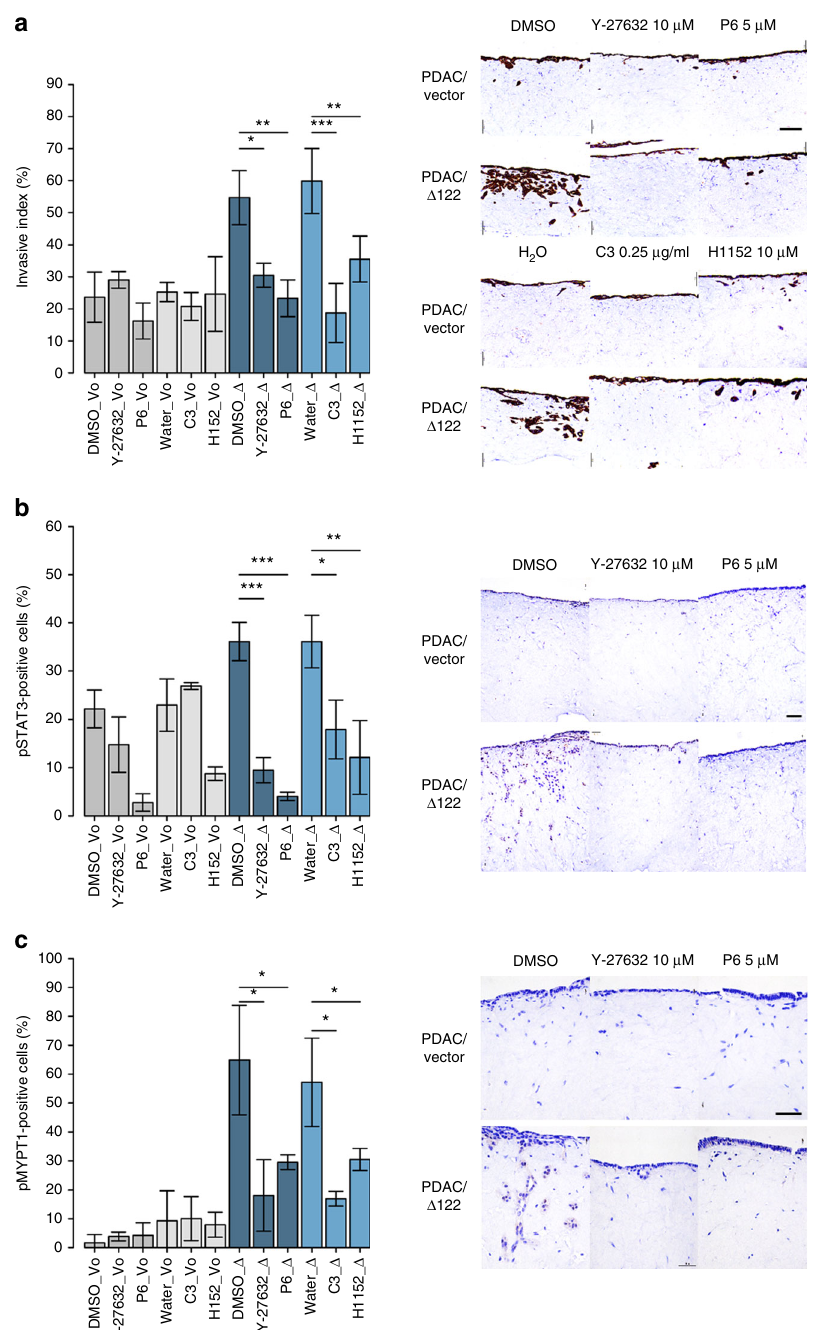
Fig. 5 Δ 122p53-expressing PDAC cells have constitutively active JAK-STAT and RhoA-ROCK signalling pathways. a Quantitation of invasive index and representative images of pan-cytokeratin s-stained sections of PDAC/vector (Vo) and PDAC/ Δ 122 ( Δ ) cells invading through collagen matrix contracted by TIFs treated with either control solvents, Pan-JAK inhibitor P6, the ROCK inhibitors Y-27632 and H1152, and the RhoA inhibitor TAT-C3, respectively. b Quantitation and representative images of pSTAT3-stained sections of invading PDAC cells upon treatment with the above inhibitors. c Quantitation and representative images of pMYPT1-stained sections of invading PDAC cells upon treatment with the above inhibitors. Scale bar = 100 μ m. The bars represent the mean and error bars represent ± s.e.m of n = 3 repeats with 3 biological replicates each. p -values were determined using unpaired t -tests. p < 0.05 was considered signi fi cant. * p < 0.05, ** p < 0.005 and *** p < 0.0005 are designated,